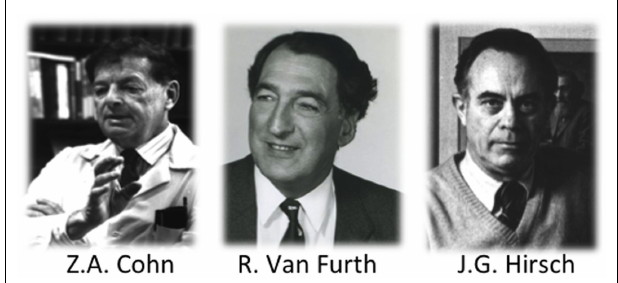
FIGURE 1 | Selected experimental pathologists and immunologists who coined the term mononuclear phagocyte system